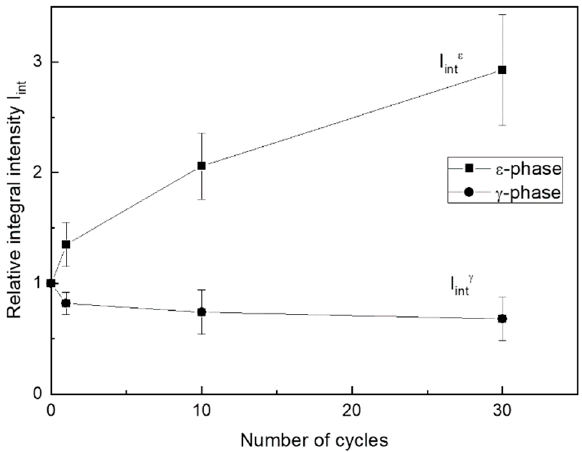
Figure 10. Changes in the relative integral intensity of X-ray lines during mechanocycling. Fe-30Mn- 5Si alloy, HR 800 . I int ε —summarized intensities of ε -phase lines; I int γ —intensity of 222 γ line.